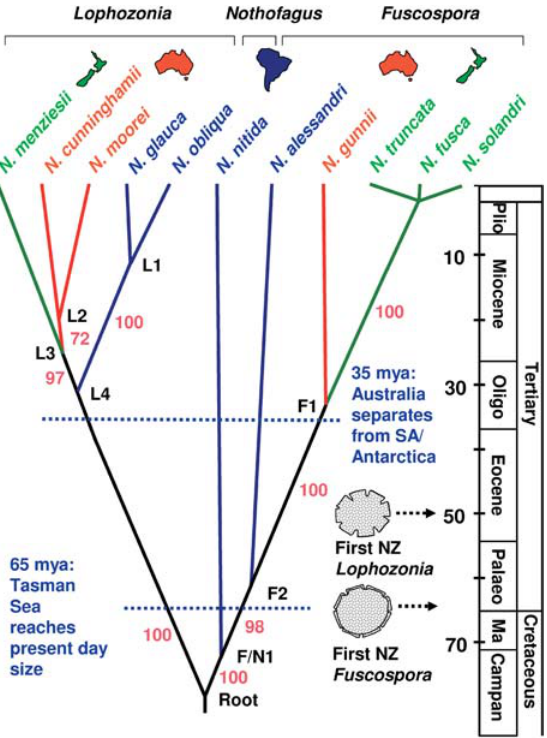
Figure 2. ML Tree Indicating Evolutionary Relationships for Nothofagus Species Based on the atpB–psaI and trnL–trnF Region of the Chloroplast Genome (7,269 bp)